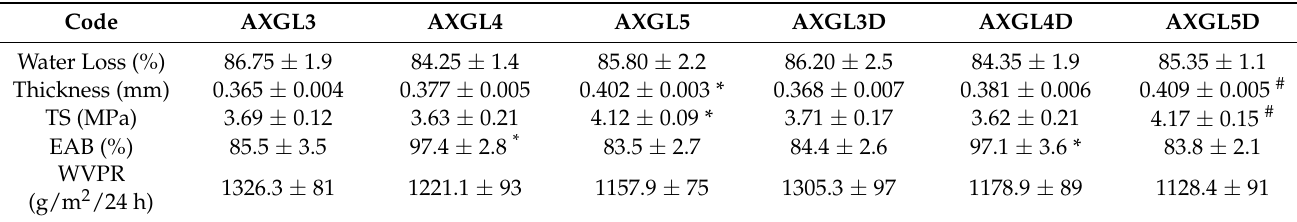
Table 2. Water loss, thickness, tensile strength (TS), elongation at break (EAB), and vapor transmission rate (WVTR) of AX-GL films (mean ± SD, n =